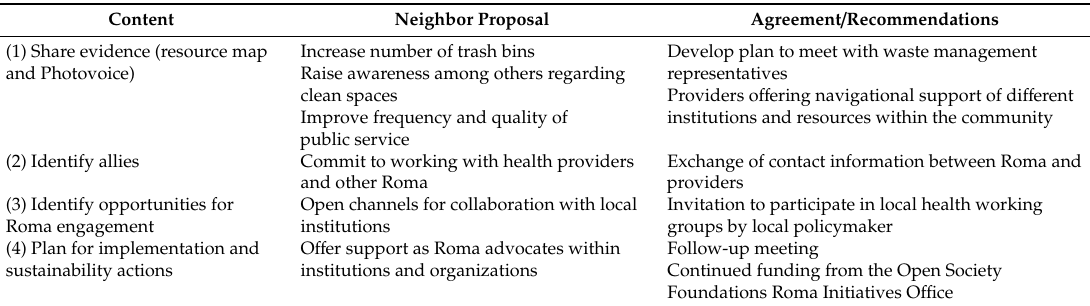
Table 3. A workshop was held between neighbors and health providers. During this workshop, partners organized content and participants developed a series of proposals that were negotiated into the agreements / recommendations presented